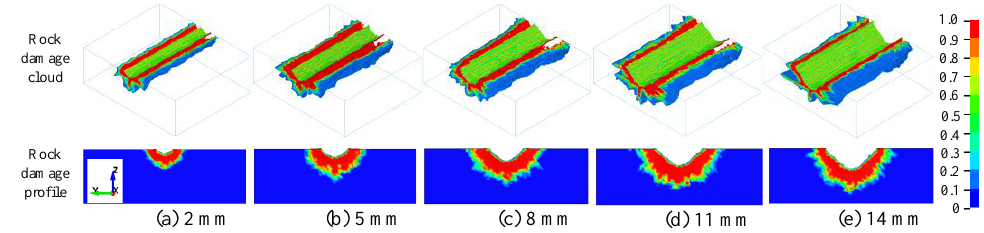
Figure 14. The rock damage nephogram with different cutting depths.